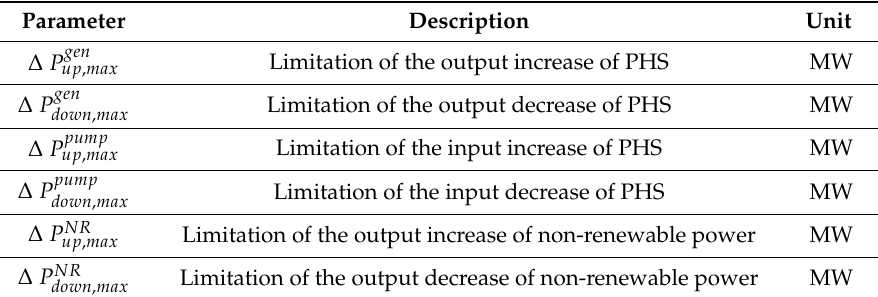
Table A8. Parameters of constraints of the power station.